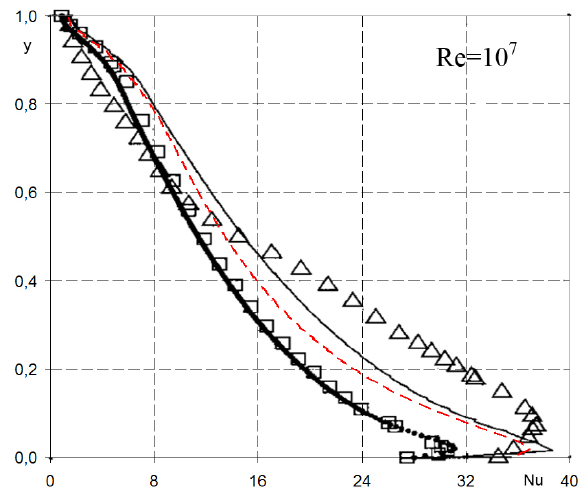
Figure 8: The local Nusselt number at Re = 10 7 ( •• [2], △△ [3], [4], −−